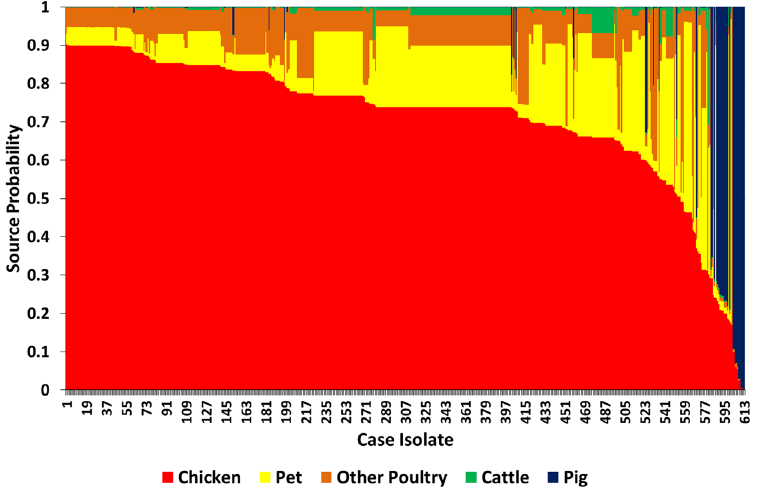
Figure 3. Source probabilities for human isolates (n = 613) to originate from each of the five sources (chicken, pet, pig, cattle, poultry other than chicken) as determined by source attribution analysis. MLST data from animal and food isolates obtained in Germany and in neighbouring European countries was used for source attribution analysis (Table